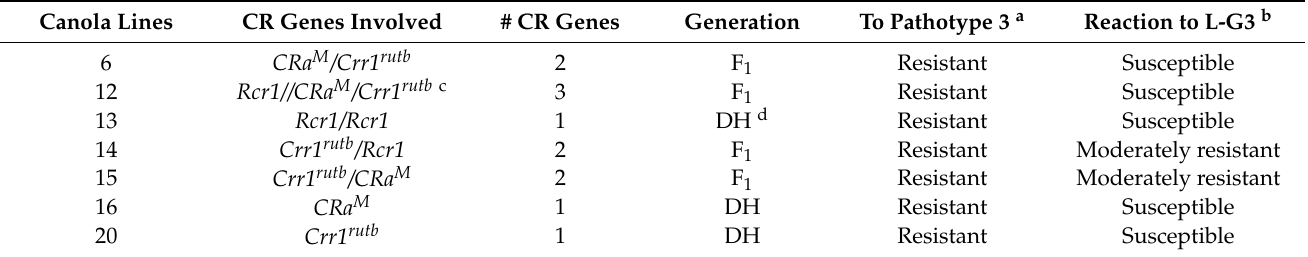
Figure 1. Diagrammatic illustration of the protocol used to conduct five cycles of continuous exposure of selected canola lines carrying different numbers or combinations of CR genes. A resting spore suspension of Plasmodiophora brassicae was added to the soil at the beginning of the first cycle to initiate the infection, and canola in subsequent cycles was infected by retained inoculum from previous rounds. Table 2. Canola inbred/hybrid lines carrying different numbers or combinations of CR genes used for studying resistance durability against a field population of Plasmodiophora brassicae pathotype X (L-G3) under controlled-environment